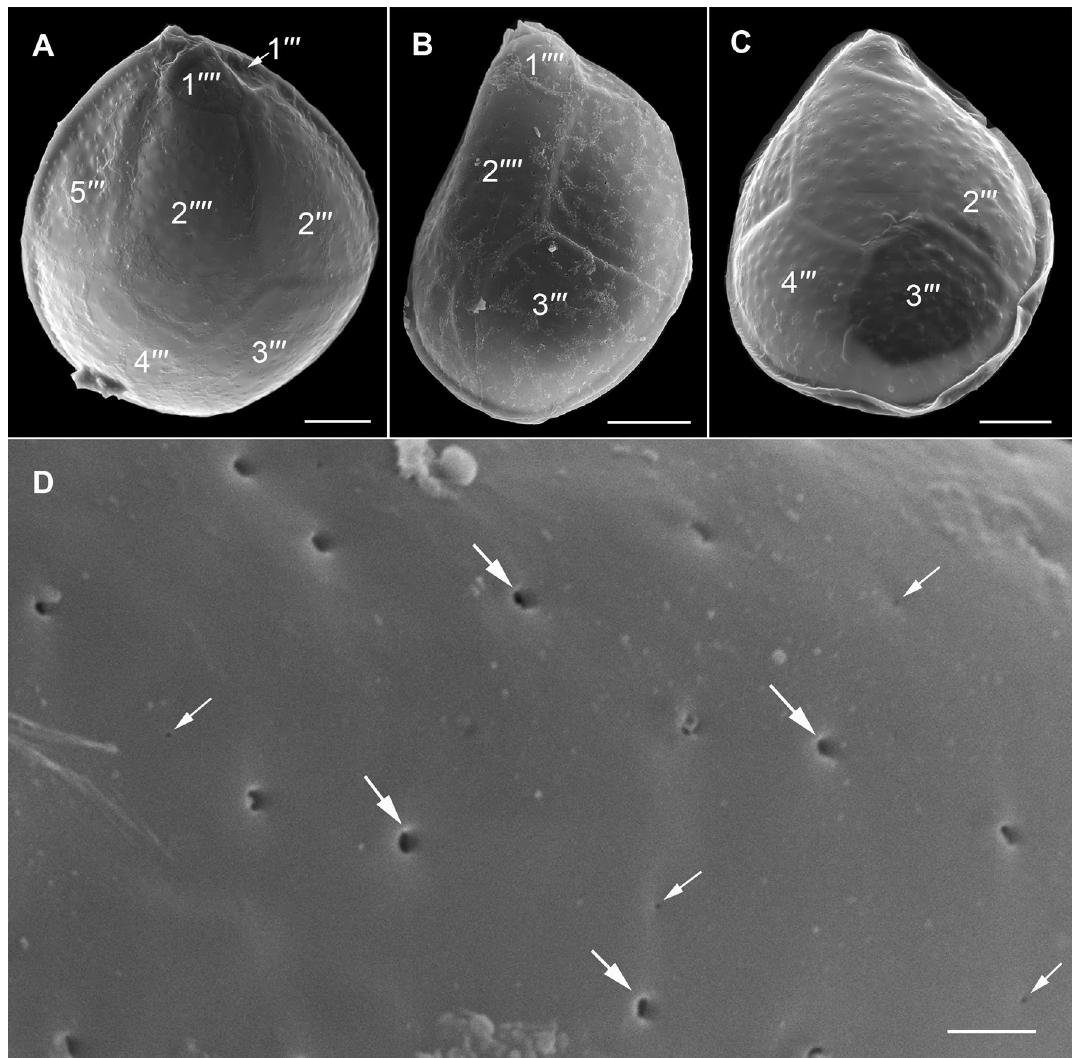
Figure 4. Scanning electron micrographs of Ostreopsis tairoto sp. nov. cells from field samples showing the hypothecal tabulation and thecal pores. ( A ) Antapical to ventral view. ( B ) Left lateral to antapical view. ( C ) Antapical to dorsal view. Note the different cell shapes. ( D ) Pores of two size classes, main larger pores (large arrows) and tiny pores (small arrows) only recognizable with very high magnification. Scale bars = 10 µm, except D: 1